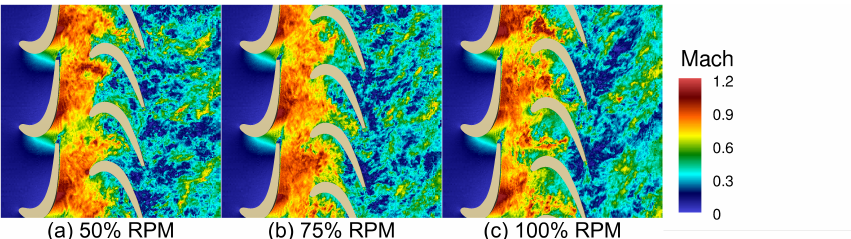
Figure 19. Instantaneous Mach number contours near the stator–rotor region at 90% span location of the rotor blade: ( a ) 50% RPM; ( b ) 75% RPM; and ( c ) 100% RPM.